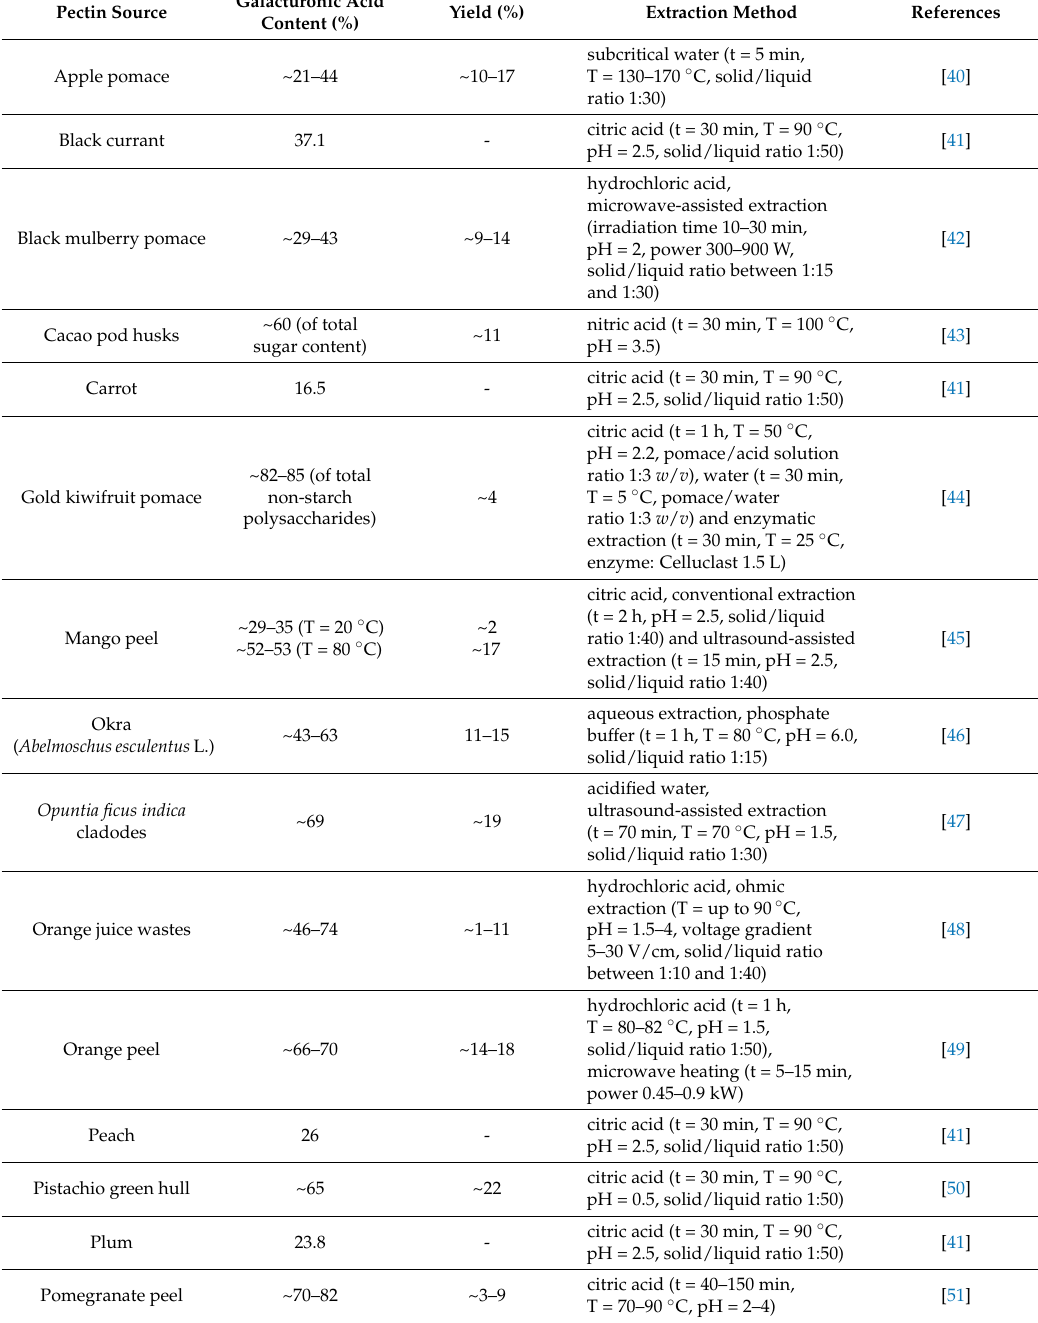
Table 1. Galacturonic acid content and yield of pectin depending on the source and method of